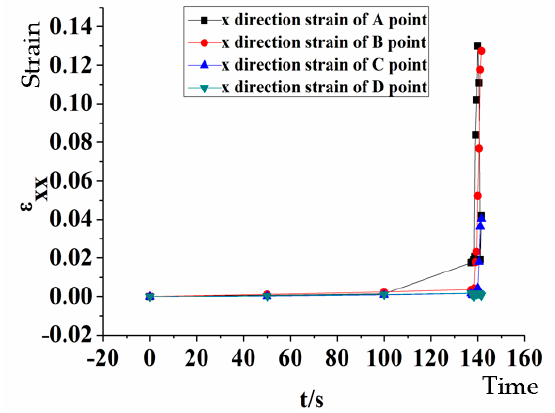
Figure 6. Strain–time profile along the x-direction (loading rate = 0.1 MPa / s).